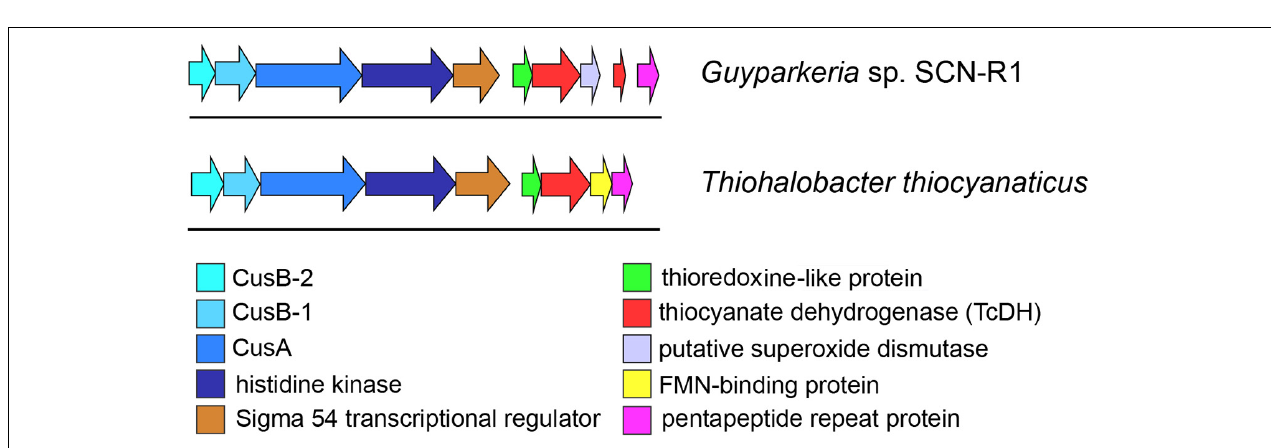
FIGURE 4 | Fragment of a multiple alignment of TcDH sequences, containing residues of the enzyme’s active site marked by asterisks: Lys103, His135, His136, Gln156, His206, Glu288, Asp314, His381, His437, His482, His528, Asp529, Arg544. Color intensity is proportional to residue conservation. The top sequence corresponds to the model TcDH from Thioalkalivibro paradoxus ARh1 with known crystal structure (PDB ID 5F75), the last two sequences are TcDH homologs from Thiohalobacter thiocyanaticus HRh1 T and Guparkeria SCN-R1. Gaps between alignment fragments are represented by dashed lines.